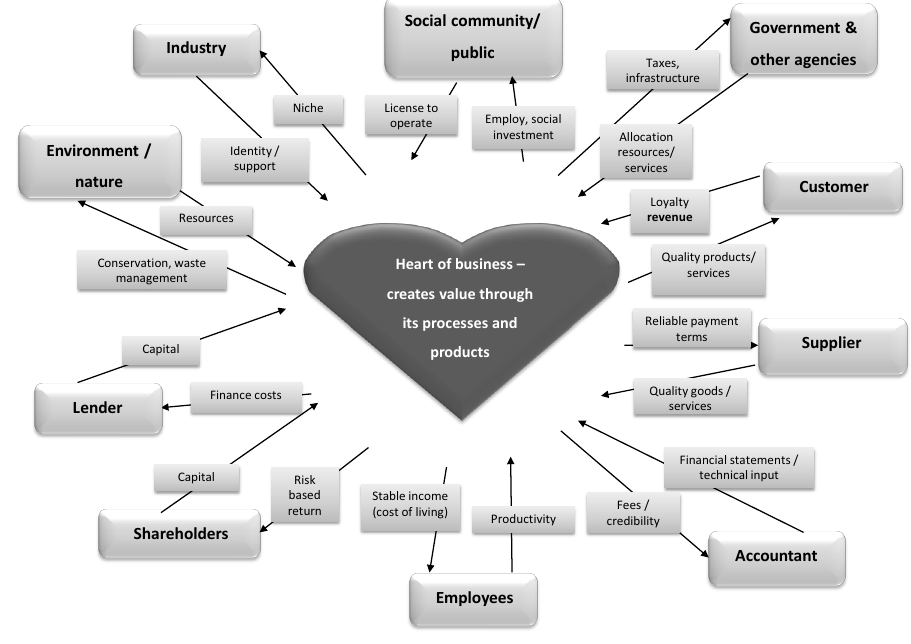
FIGURE 1: The circle of business life